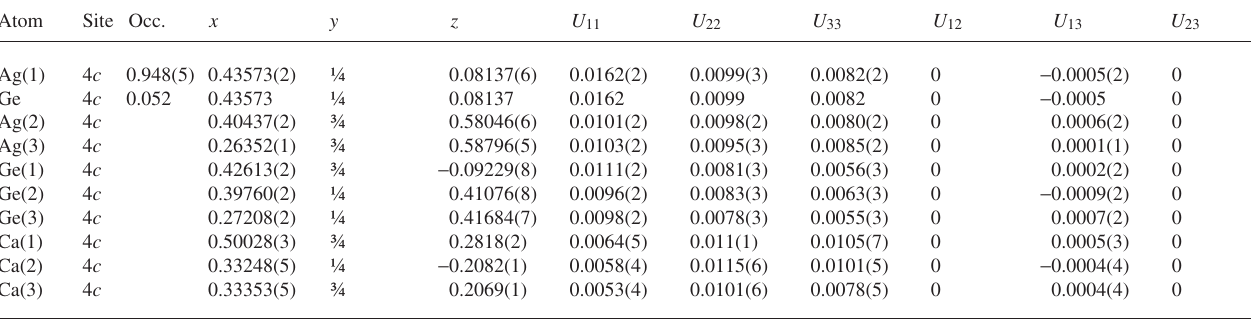
Table 2. Atomic coordinates and displacement parameters (in Å 2 ) . Atom Site